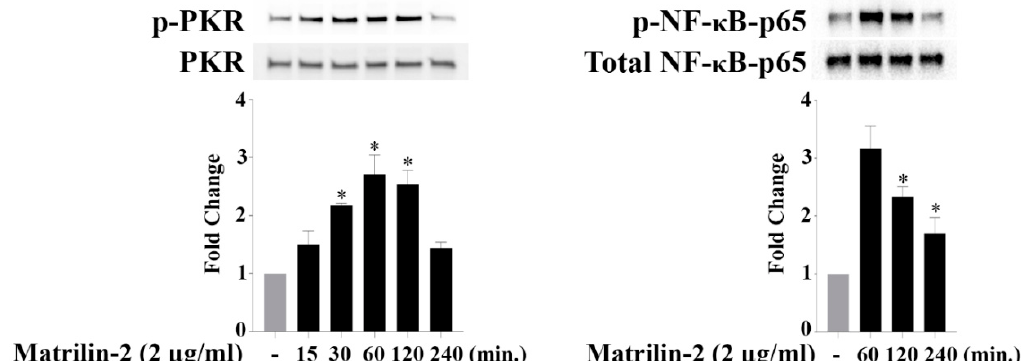
Figure 2. Matrilin-2 activates PKR and NF- κ B in human AVICs. Human AVICs were stimulated with recombinant matrilin-2 for varied durations. Stimulation with recombinant matrilin-2 resulted in increased levels of phospho-PKR and phospho-NF- κ B. Values are means ± SE. n = 5 experiments using distinct cell isolates; * P < 0.05 vs. control.